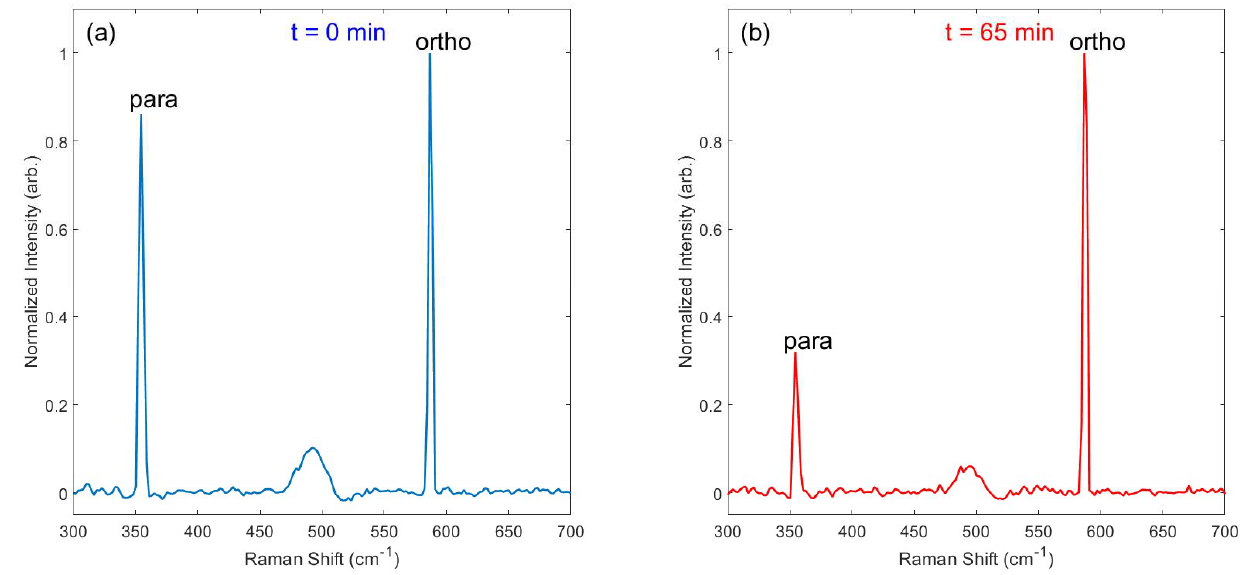
Figure 4. Example Raman spectra of the J : 0 → 2 ‘para’ spin peak (355 cm −1 ) and J : 1 → 3 ‘ortho’ spin peak (586 cm −1 ), taken both ( a ) immediately after loading the pH 2 -enriched gas into the valved NMR tube and ( b ) after 65 h had elapsed. The relative abundances of the two spin isomers can be determined from their relative peaks (e.g., the pH 2 fraction is nearly 50% at t = 0 and reverts to the thermal equilibrium value of 25% within 65 h). See Supplemental Figure S2 for a version of this plot with the peaks overlaid, demonstrating consistent shift and linewidth between time points.